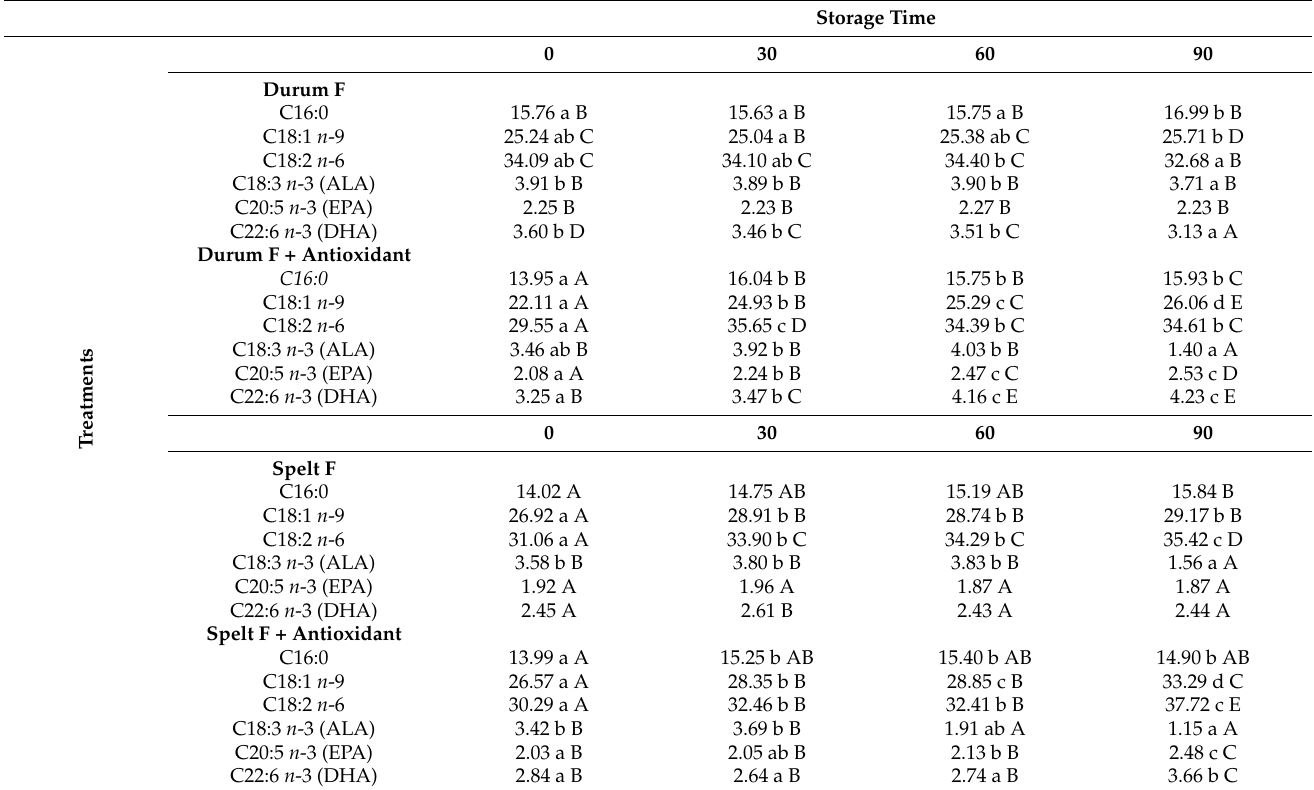
Lower case letters within each row for the same pasta with or without antioxidant show significant differences ( p < 0.05) in sampling times inside each treatment. Capital letters within columns show significant differences ( p < 0.05) between treatments (with or without antioxidant) throughout the shelf life for each group of pasta (durum and